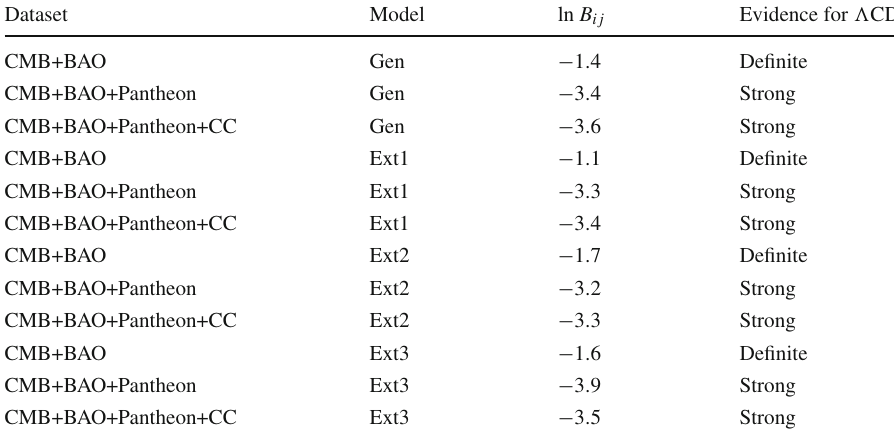
Table 8 The values of ln B ij computed for the present dark energy parametrizations ( M i ) where the reference scenario is the (cid:2) CDM model ( M j ). We note that the negative value of ln B ij means that (cid:2) CDM is